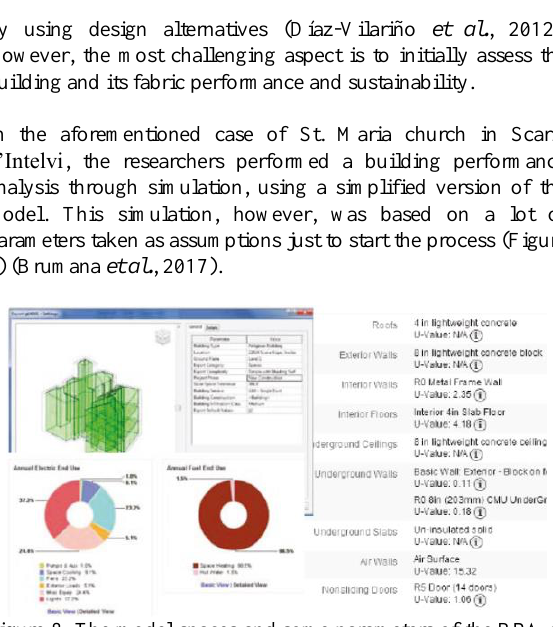
Figure 8: The model spaces and some parameters of the BPA of St. Maria church. (Brumana et al. , 2017)